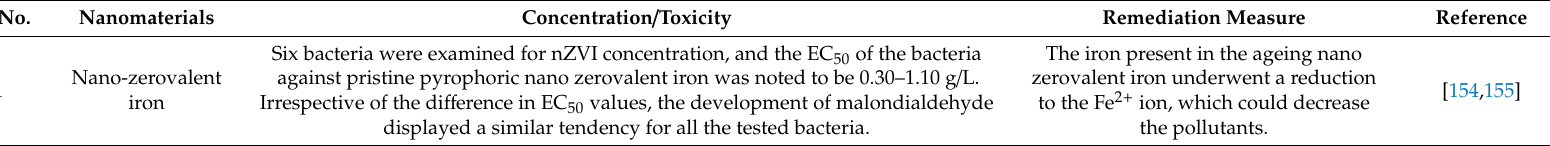
Table 4. The toxicity as well as the function of di ff erent commonly used nanomaterials in the aqueous environment. Sl.